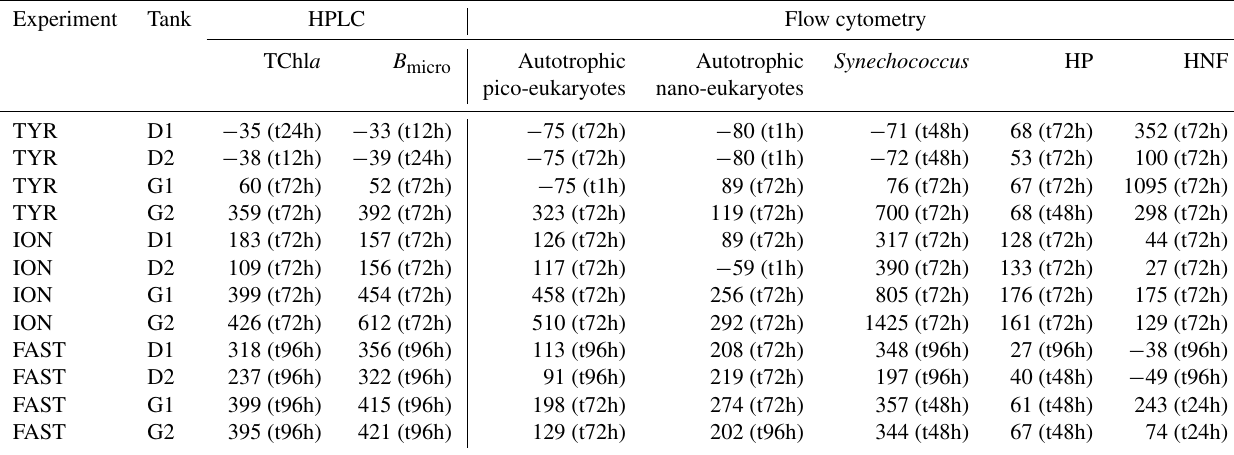
Table 5. Percent (%) maximum relative changes in tanks D and G as compared to controls (average between C1 and C2), for the experiments TYR, ION and FAST. The sampling time at which these maximum relative changes were observed is shown in brackets. Tchl a refers to the concentration of total chlorophyll a and B micro to the biomass proxy of micro-phytoplankton (sum of Fucoxanthin and Peridinin, see Material and methods) based on high-performance liquid chromatography (HPLC). HP and HNF refer to heterotrophic prokaryote and heterotrophic nanoflagellate abundances, respectively, measured by flow